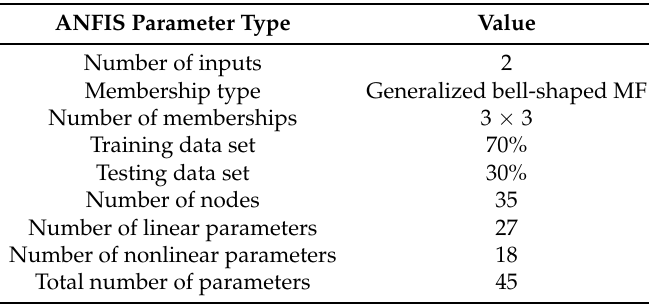
Table 2. ANFIS structure information.